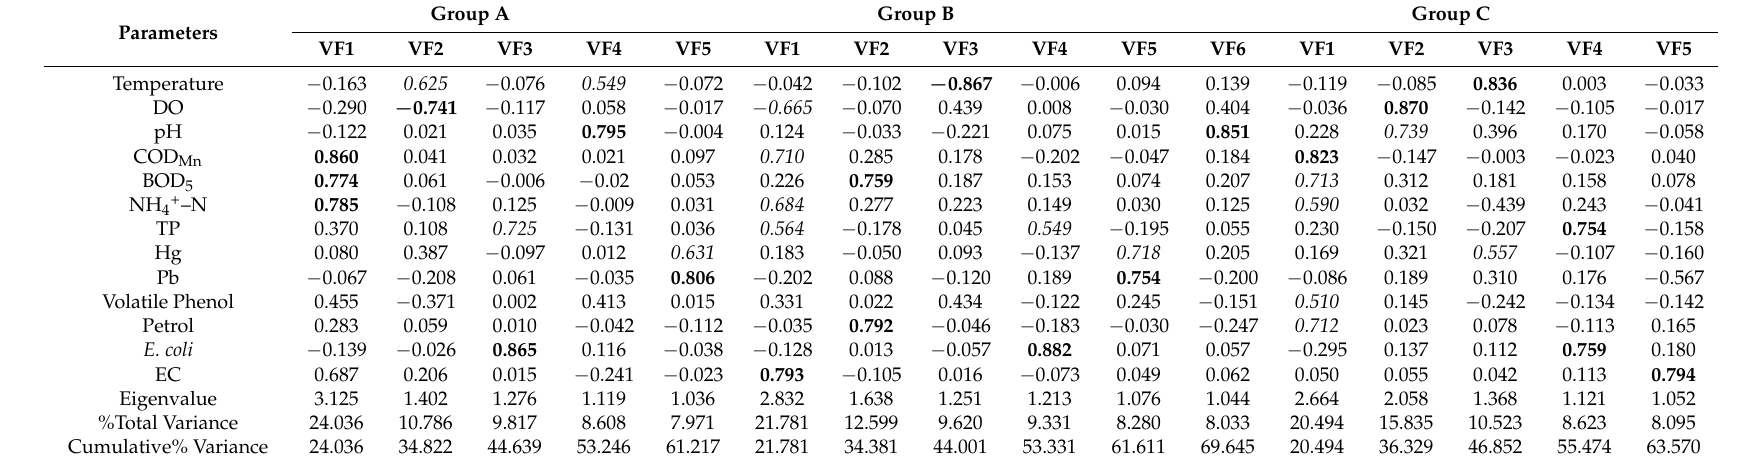
Table 3. Loading of 13 water quality variables on significant varifactors (VFs) for group A, group B and group